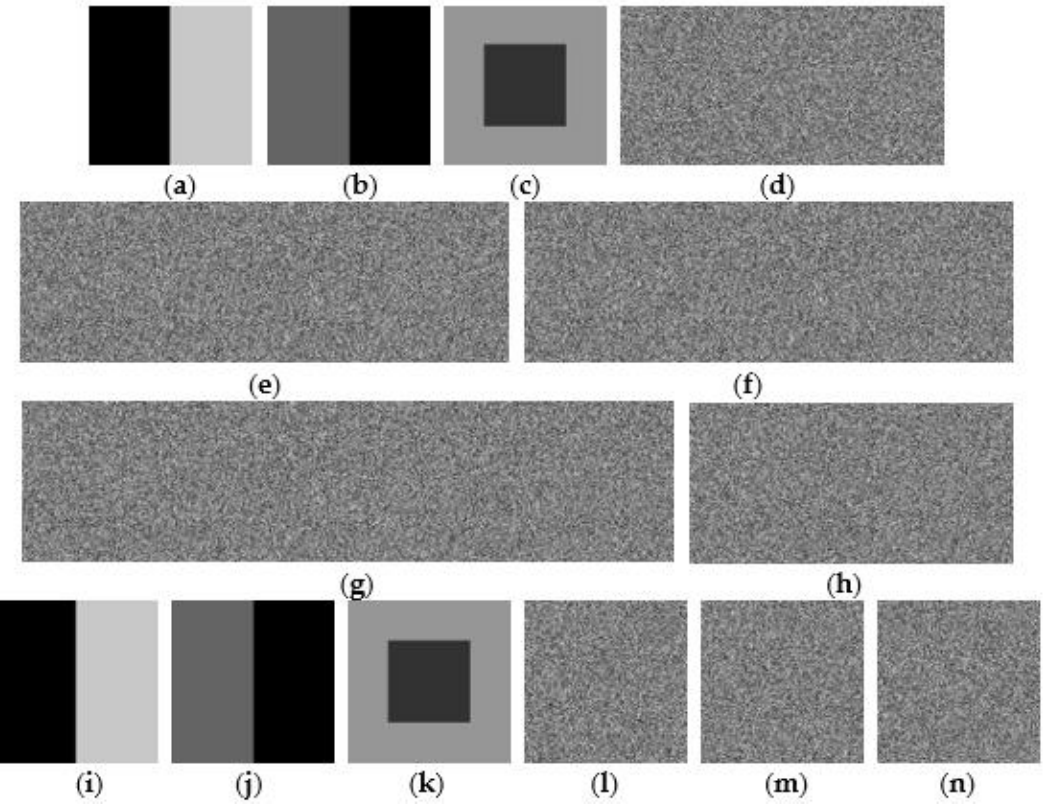
Figure 10. Results of the second proposed (3, 5, 3) SRS method. ( a – c ): secret images with size